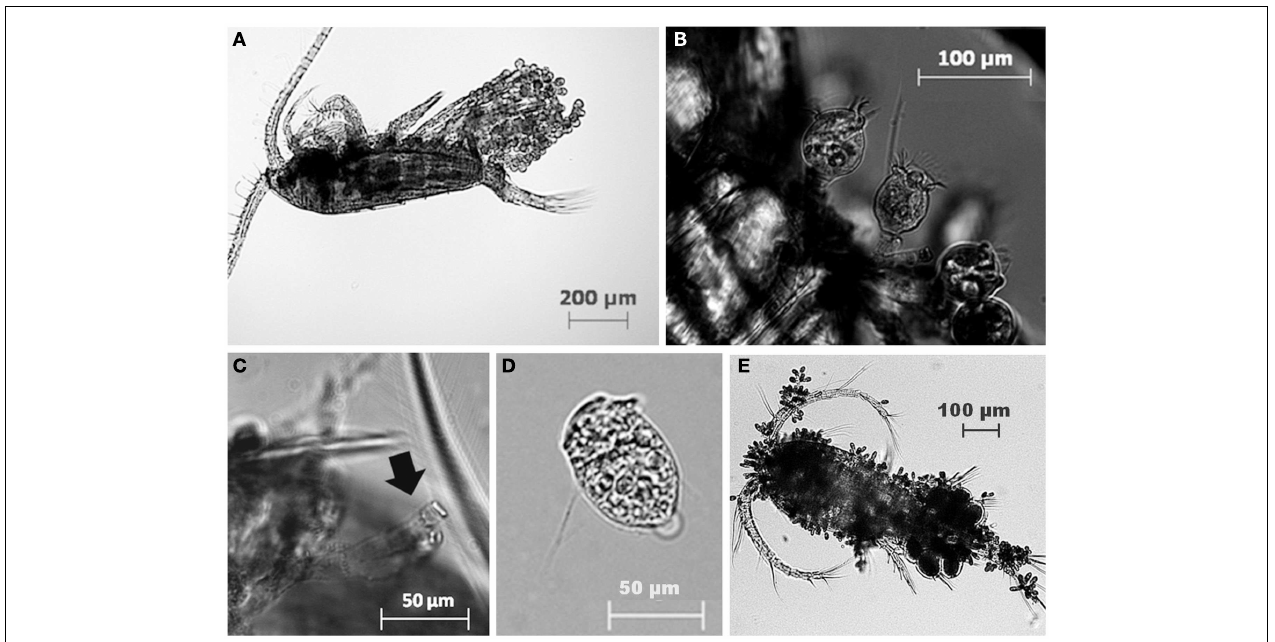
FIGURE 2 | Examples of the peritrich ciliate epibiont Epistylis sp. attached to the calanoid copepod Eudiaptomus gracilis (A,B) and the residual stalk (C) left attached to the dead copepod after detachment (D). Peritrich ciliates of the family Opercularidae, attached to a cyclopoid copepod (E) .